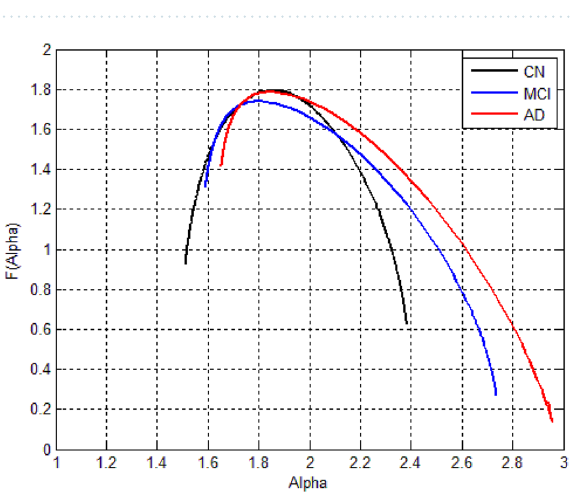
Figure 11. The singularity spectra for the AD stages (16 sample images-Kaggle).